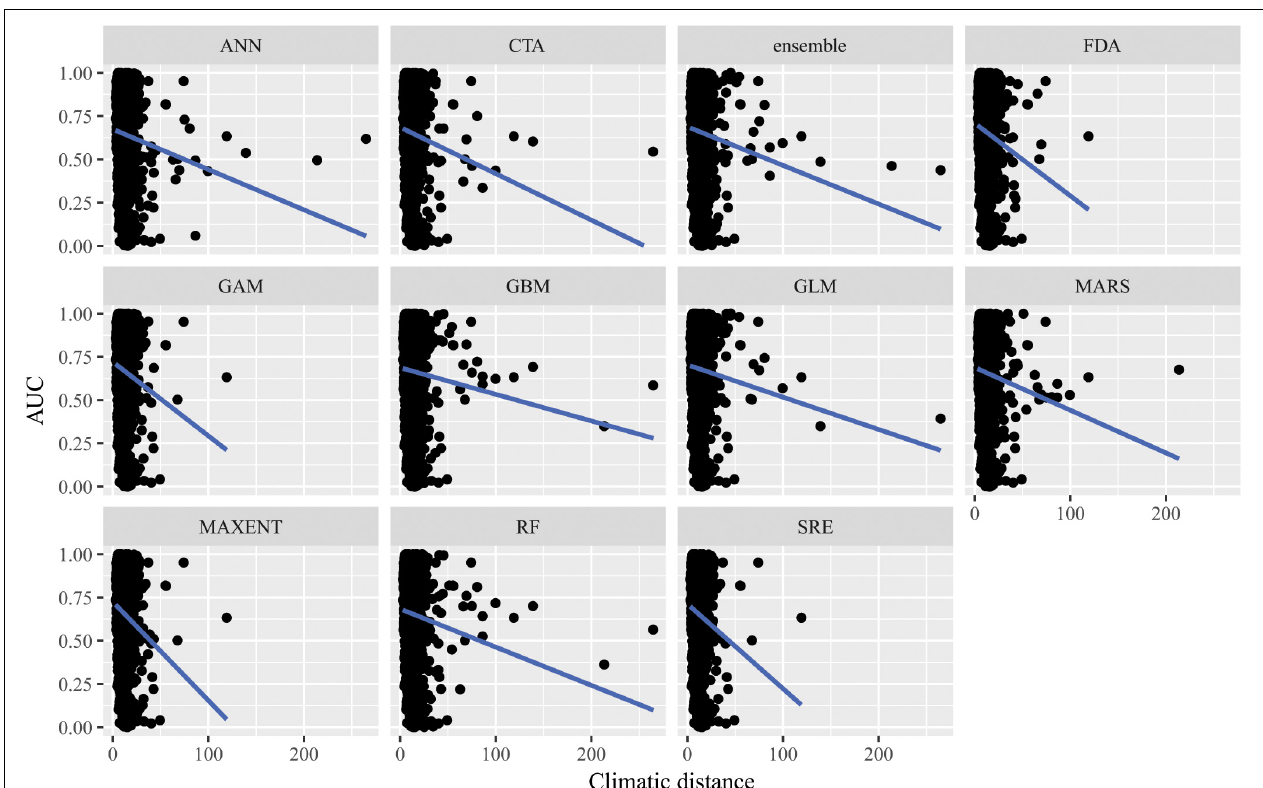
FIGURE 7 | Predictive performance of species distribution models with different algorithms as measured with AUC versus distance of extrapolation in environmental space in a novel geographic region. Distance was measured by first normalizing the distance along each variable axis, then calculating Euclidean distance, and finally dividing by the square root of the number of dimensions (i.e., 19) to obtain a normalized distance in standard-deviation